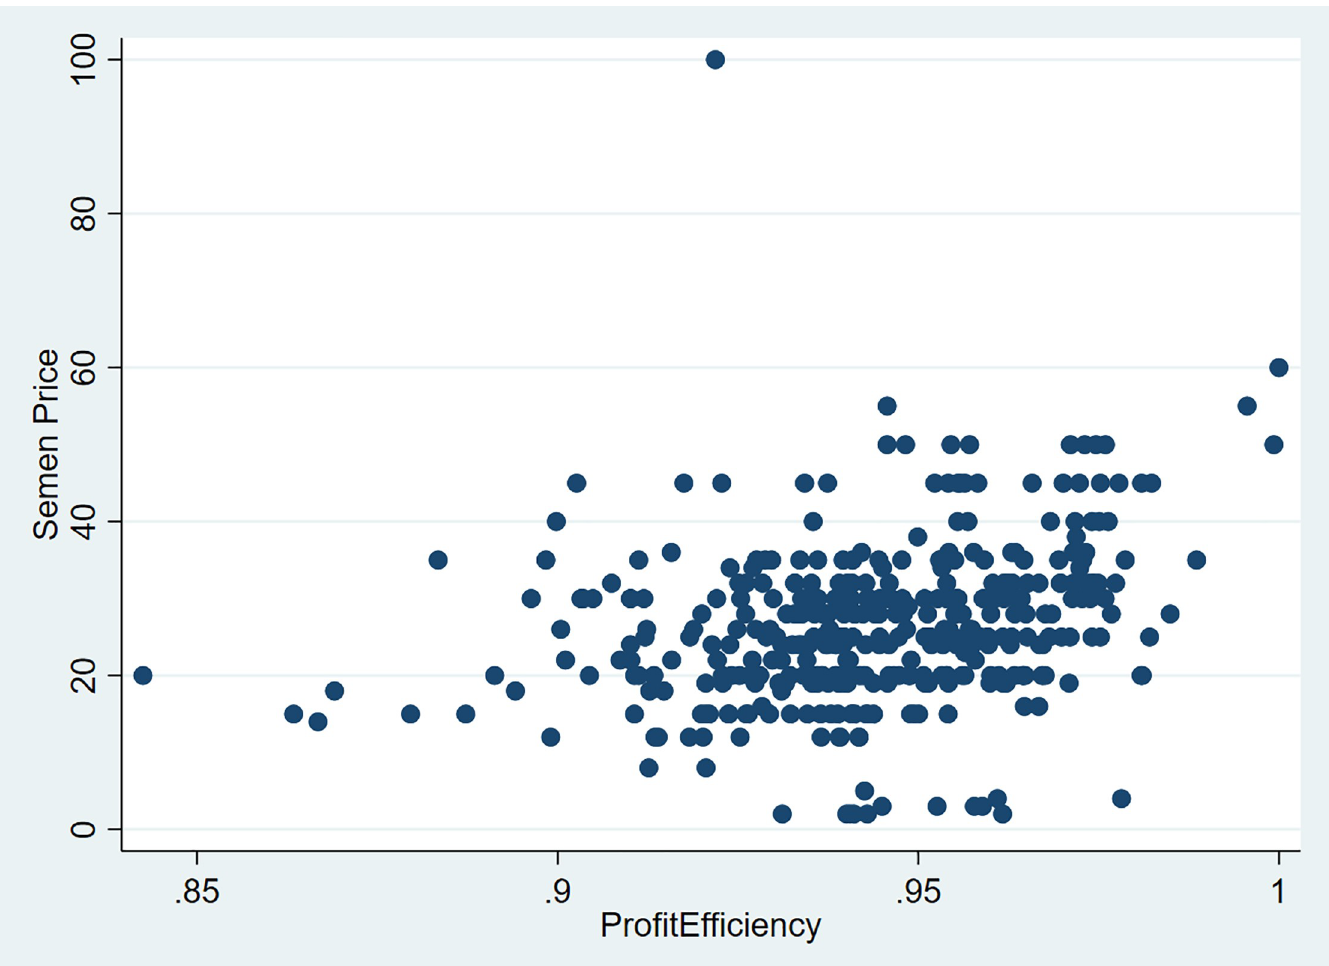
Fig 5. Scatter plot of semen price versus profit efficiency from the two output (fat, protein), one input (semen)